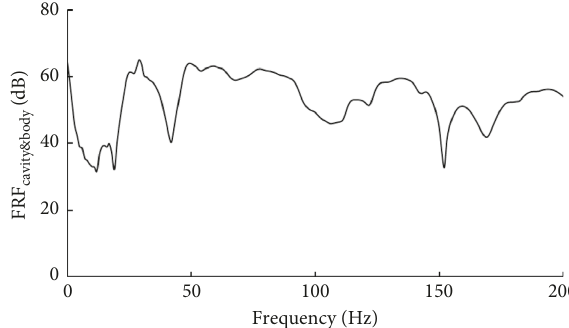
Figure 26: Frequency response function of cavity & body.